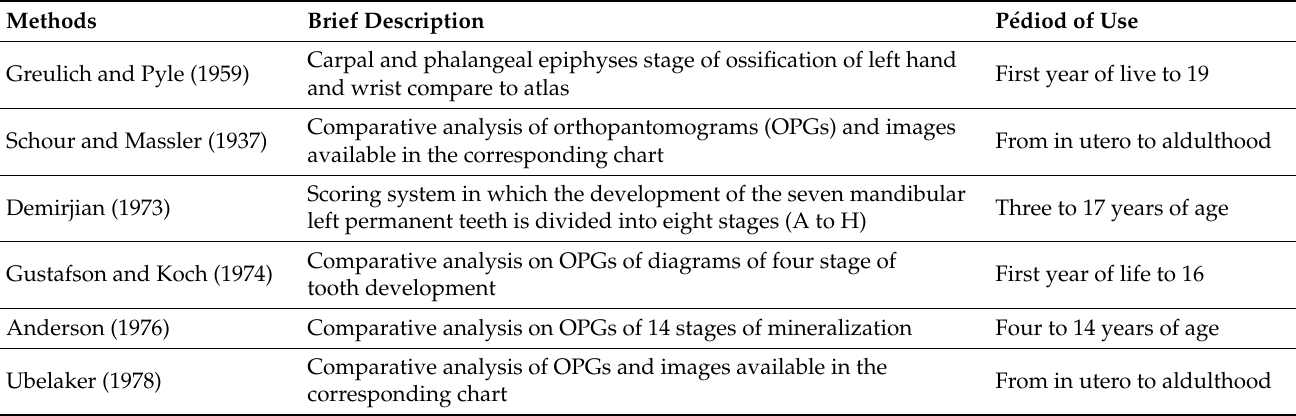
Table 5. Description of the methods used in the